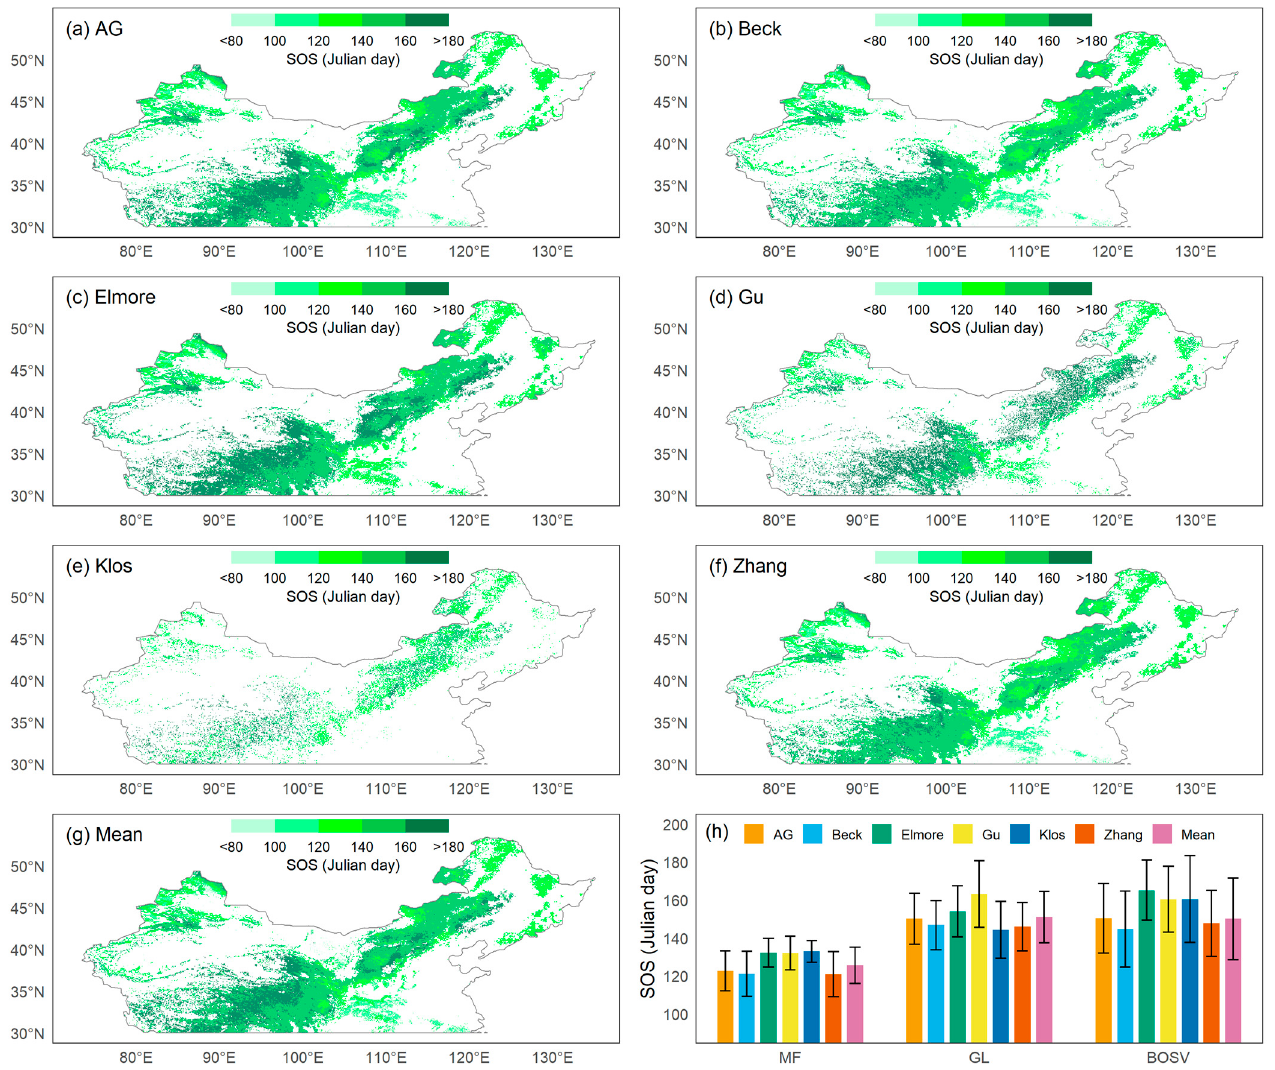
Figure 2. Spatial patterns of the mean start of the growing season (SOS) from 1982 to 2015 using six methods: ( a ) asymmetric Gaussian method (AG), ( b ) Beck’s method (Beck), ( c ) Elmore’s method (Elmore), ( d ) Gu’s method (Gu), ( e ) Klosterman’s method (Klos), ( f ) Zhang’s method (Zhang), and ( g ) the mean of all methods (Mean). ( h ) The means and standard deviations of SOS for 1982–2015 estimated by six methods and their means for the three vegetation types: mixed forests (MF), grasslands (GL), and barren or sparsely vegetated land (BOSV).